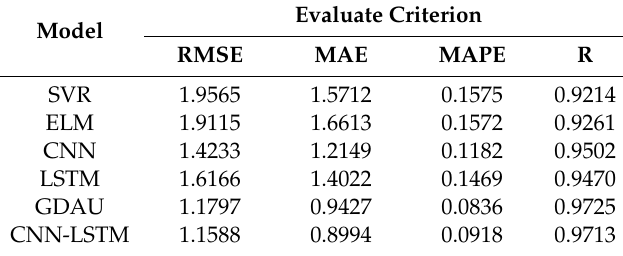
Figure 12. The structure of different models . In Figures 13–15, it can be seen that the prediction results of the compared models can approximately fit the actual values with little error. Moreover, the hybrid CNN-LSTM model performs best in RMSE, MAE and MAPE. The RMSE of CNN, LSTM, and GDAU are 1.4233, 1.6166, and 1.1797, respectively. Similarly, the MAE value of CNN-LSTM model is slightly lower than that of compared model. As seen in Table 5, the R value of CNN-LSTM model is 0.9713, which is obviously higher than that of CNN 0.9502 and LSTM 0.9470. The results illustrate the hybrid CNN-LSTM can effectively improve the prediction accuracy by integrating the excellence of CNN in local feature extraction and good expression of LSTM on time series features.